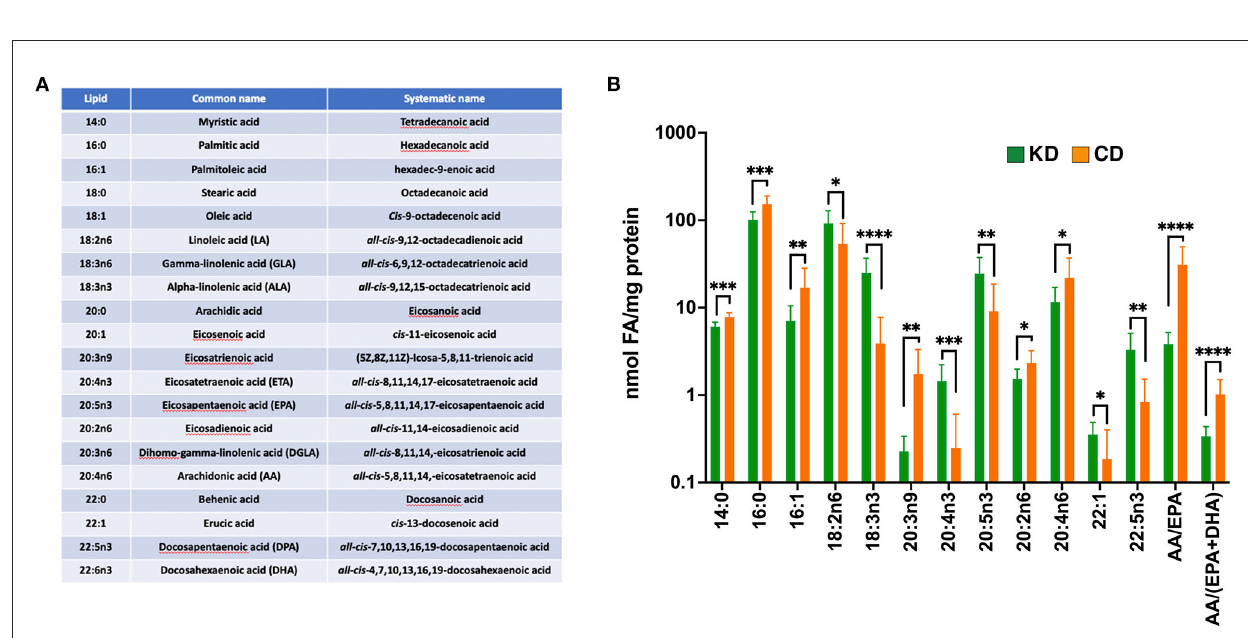
FIGURE5 The KD increases plasma ω 3 fatty acid content and suppresses levels of pro-inflammatory ω 6 fatty acids. (A) List of fatty acids analyzed with the accompanying omega designations (aka. lipid), common names, and systematic names. (B) Graph depicting nmols of individual fatty acids per mg of protein in the plasma that are statistically significantly different (* p ≤ 0.05, ** p < 0.01, *** p < 0.001, **** p < 0.0001 as determined by Mann-Whitney test with Bonferroni correction) between EAE mice fed the KD (green) vs. the CD (orange). The ratio of arachidonic acid (AA; 20:4n6) to (EPA + DHA) (20:5n3 + 22:6n3) is included as a proxy of systemic inflammation. Graph uses log scale on the y -axis with data derived from n ≥ 6 mice per diet from ≥ 2 independent